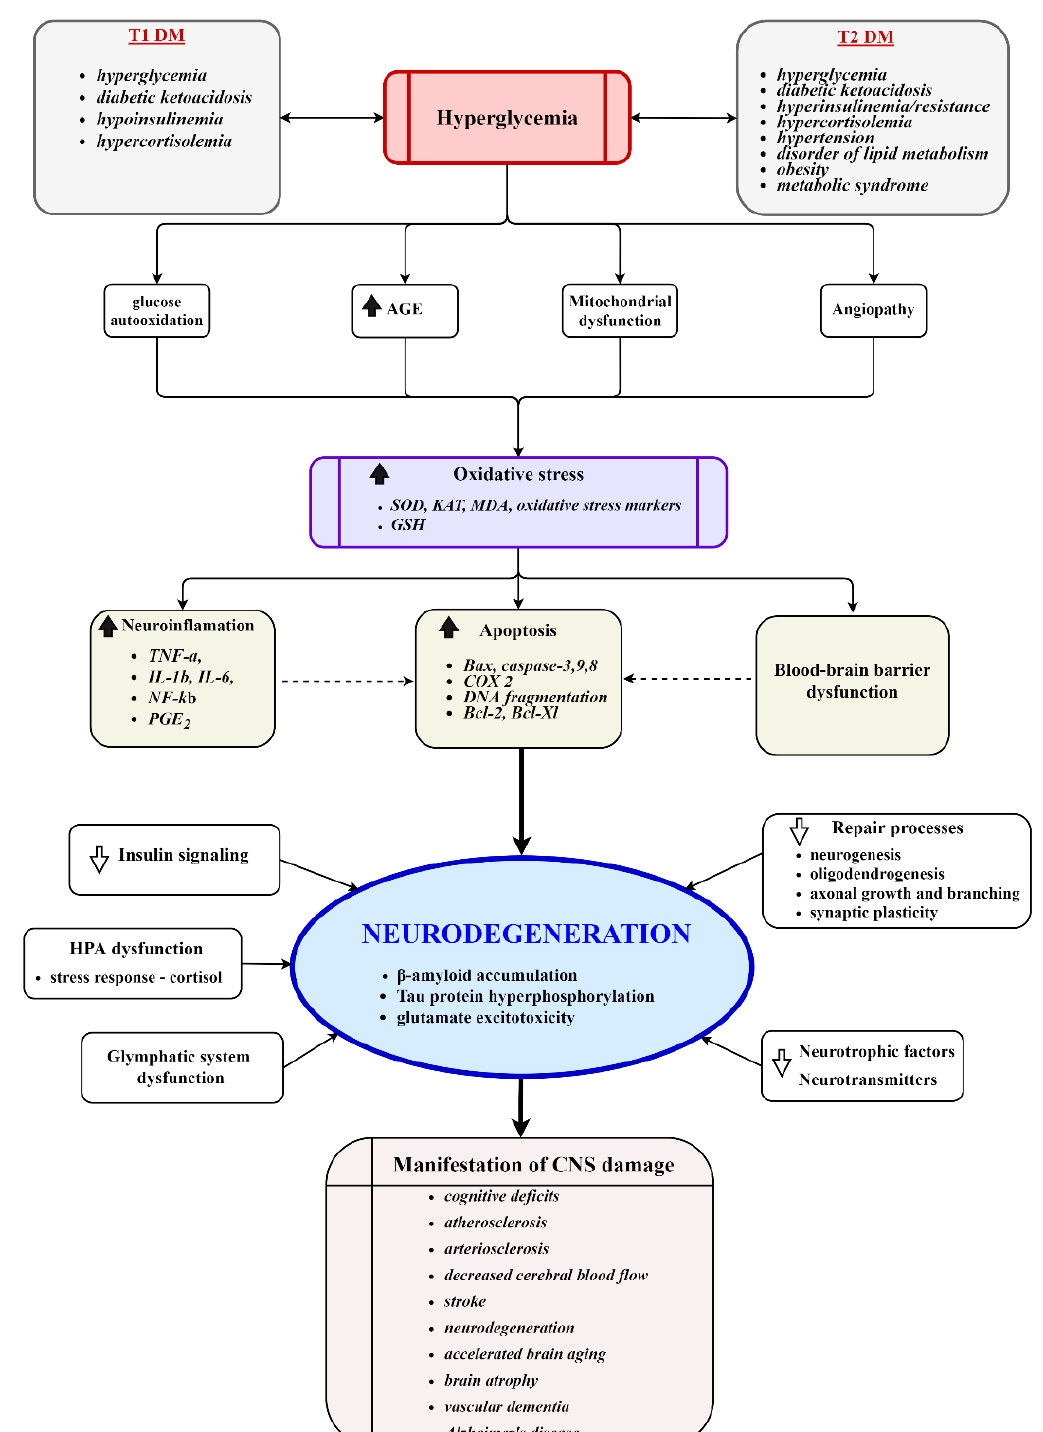
Figure 1. Key molecular events involved in the development of diabetic encephalopathy. Chronic hyperglycemia induces vascular injury, mitochondrial dysfunction, oxidative stress, neuroinflam- mation, dysfunction of the HPA axis, impairment of repair processes, reduced disposal of metabolic waste products, and activates apoptotic processes. The processes culminate in damage to the cerebral structure, neurodegeneration, and the manifestation of clinical symptoms. AGE, advanced glycation end products; SOD, superoxide dismutase; KAT, catalase; GSH, glutathione; HPA, hypothalamic–pituitary – adrenal axis.